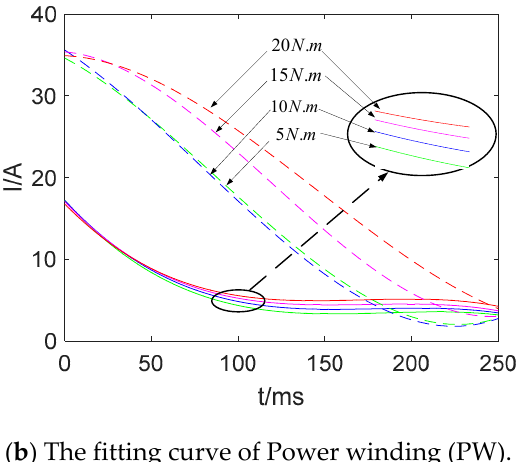
( b ) The fitting curve of Power winding (PW). Figure 20. Comparison of peak fitting curves of starting current. Figure 20. Comparison of peak fitting curves of starting current.